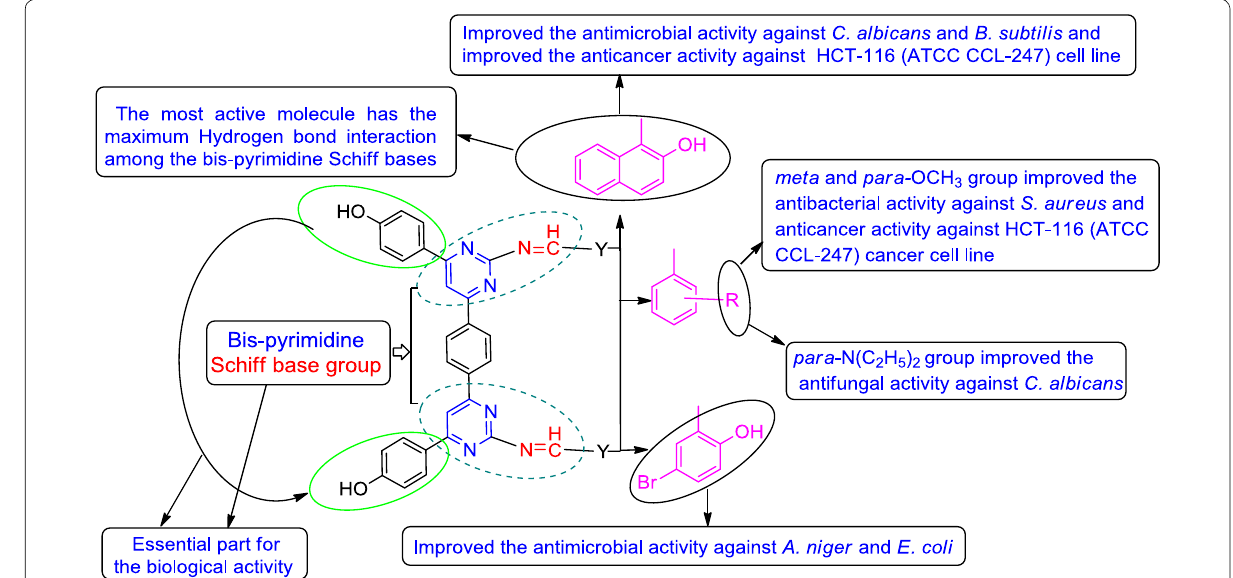
Fig. 3 Structural requirements for the antimicrobial and anticancer activities of synthesized bis-pyrimidine Schiff